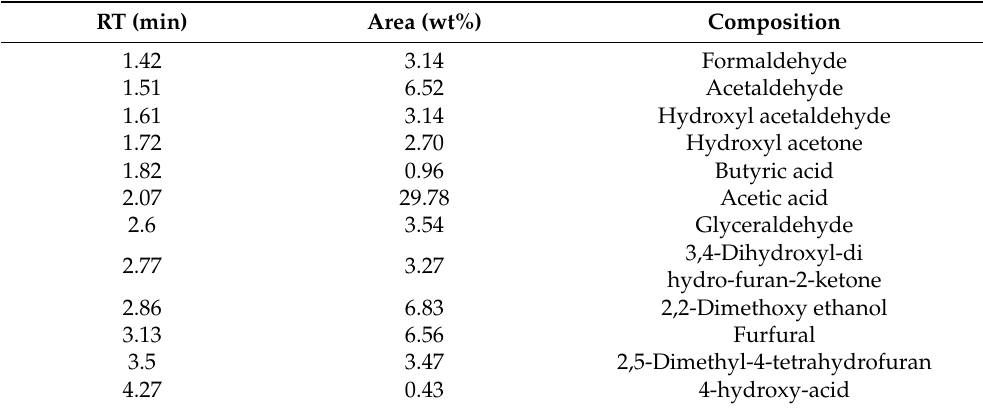
Table 1. The compositional analysis of the crude biomass fuel by